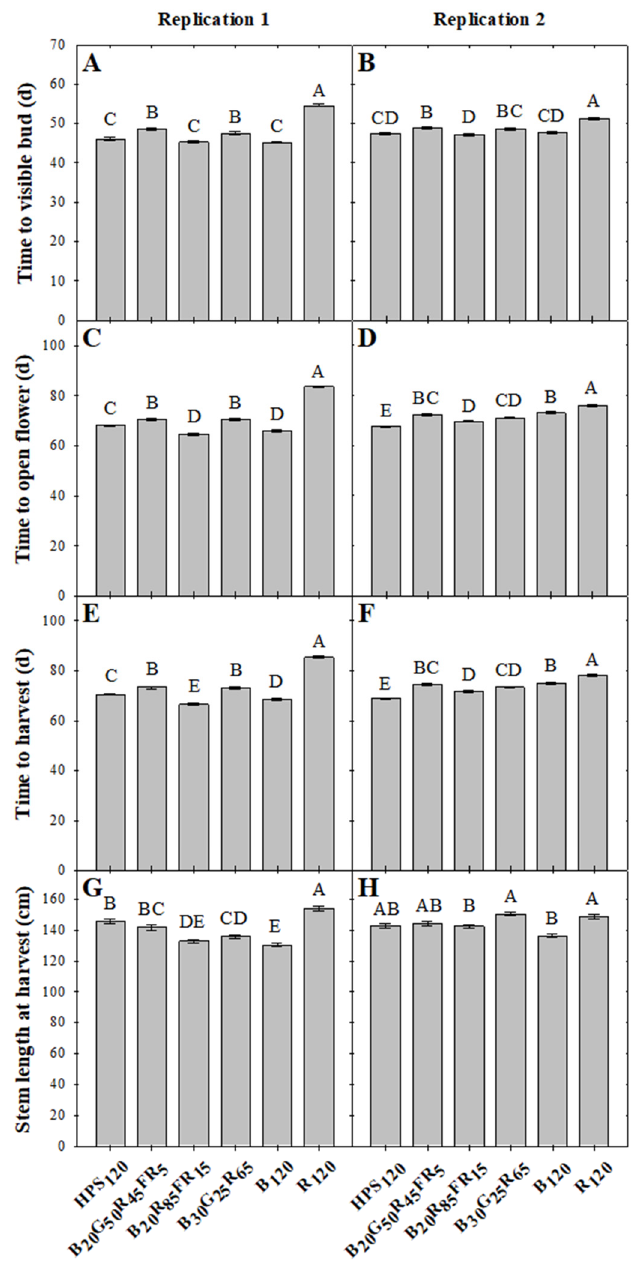
Figure 3. ( A , B ) Time to visible flower bud, ( C , D ) time to open flower, ( E , F ) time to harvest, and ( G , H ) stem length at harvest of snapdragon ‘Potomac Royal’ in response to SL spectrum over two replications. SL treatments consisted of either 460 W HPS fixtures (HPS 120 ; LR48877; P.L. Light Systems, Beamsville, ON, Canada), 631 W LED fixtures (B 20 G 50 R 45 FR 5 ; VYPR 2p; Fluence, Austin, TX, USA), 325 W LED fixtures (B 20 R 85 FR 15 ; LumiGrow Pro 325; LumiGrow, Emeryville, CA, USA), 600 W LED fixtures (B 30 G 25 R 65 ; LX601G, Heliospectra, Göteborg, Sweden), a combination of 72 W LED fixtures (B 120 ; HortiLED MULTI, P.L. Light Systems) and 625 W LED fixtures (R 120 ;